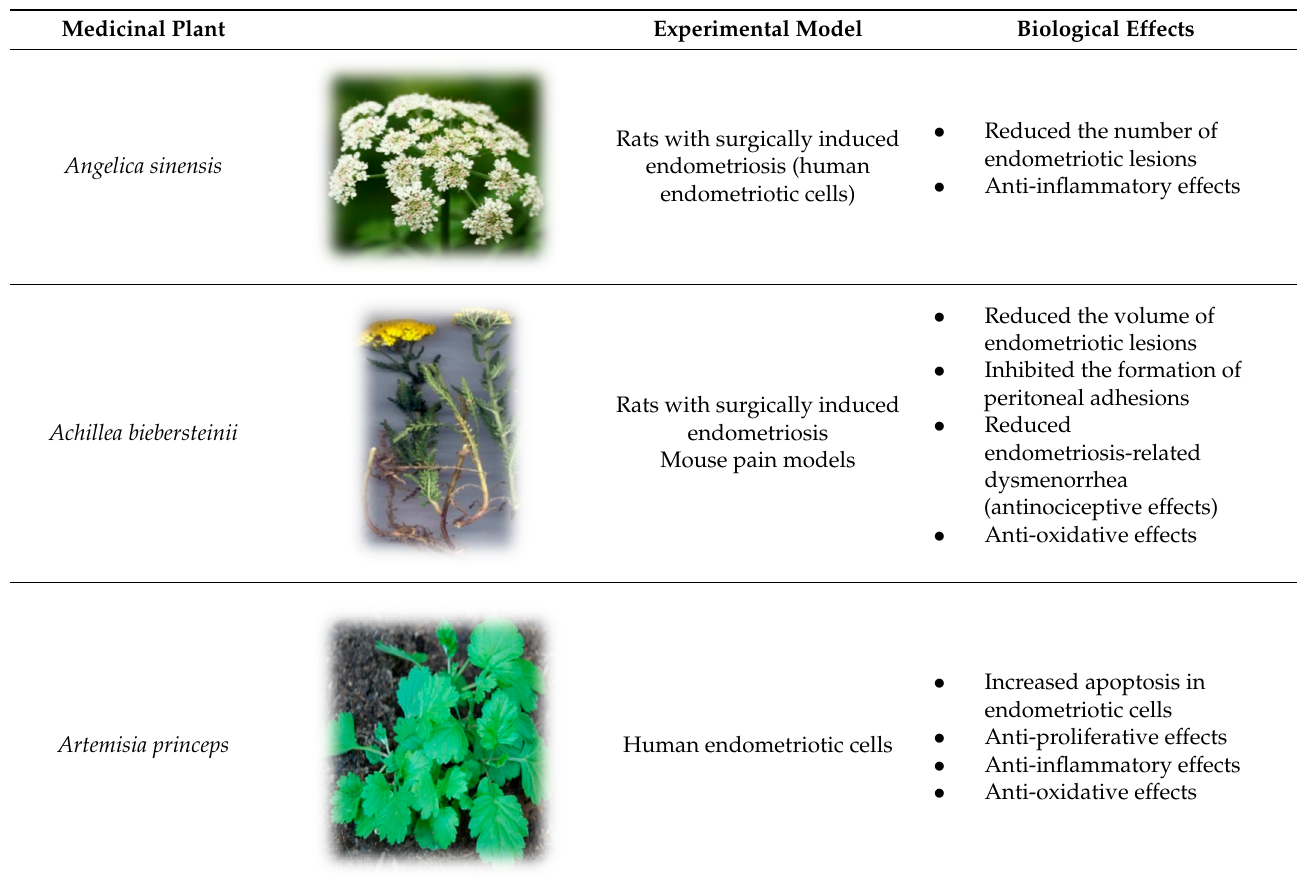
Table 1. Medicinal herbs and their effects against endometriosis.